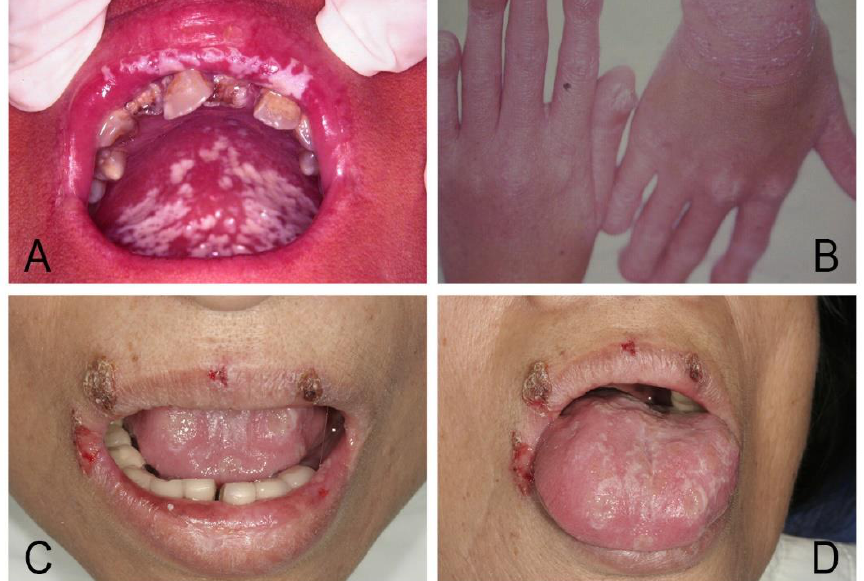
Figure 2. Chronic mucocutaneous candidosis (CMC). ( A , B ) Congenital type of CMC in a 14-year-old girl showed disfigured and clubbing nails, crusted rash of skin, and persistent oral thrush that was initially pseudomembranous and then changed to hyperplastic lesions as flat or raised white adherent plaques hard to be rubbed off; even the infection remained relatively superficial. ( C , D ) Acquired type of CMC limited to the oral and perioral sites in a 56-year-old woman with iron deficiency anemia.